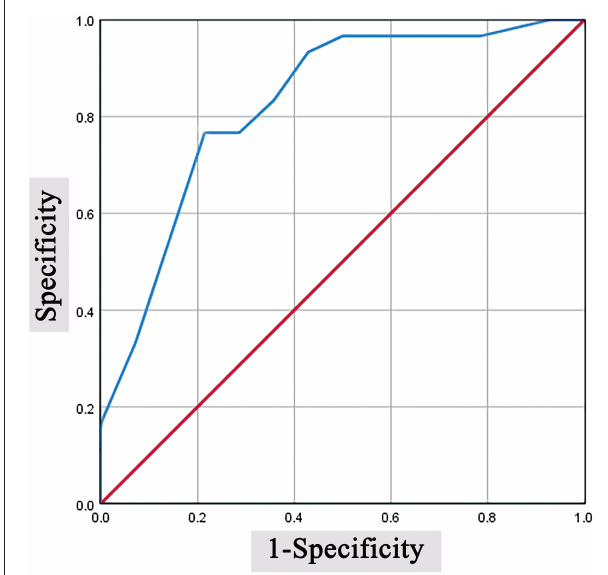
FIGURE 3 | Predictive values of surgical accuracy for overall postoperative complications. The optimal cutoff value was determined as 95.8 in the ROC curve (the sensitivity was 76.7%, and the specificity was 86.7%). ROC, receiver operating